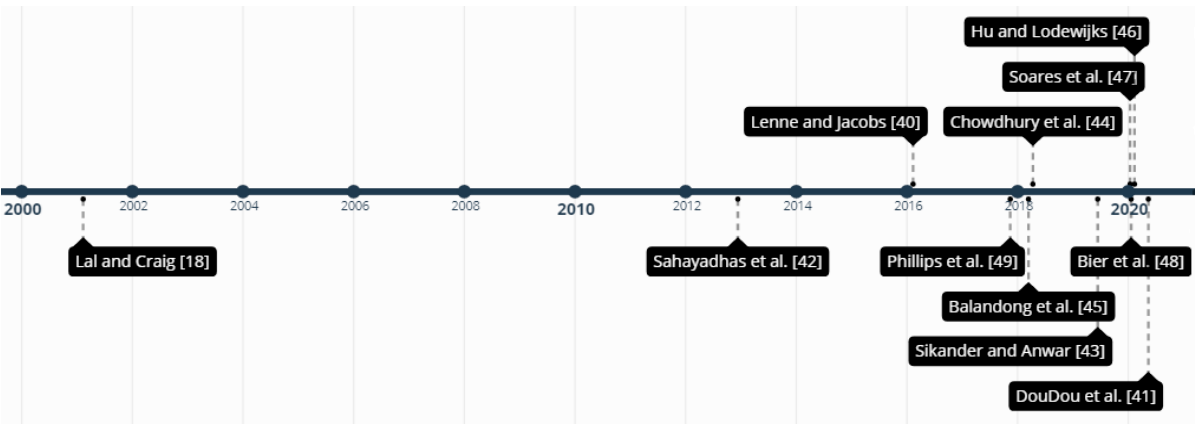
Figure 2. Chronologically ordered reviews of driver drowsiness detection methods.